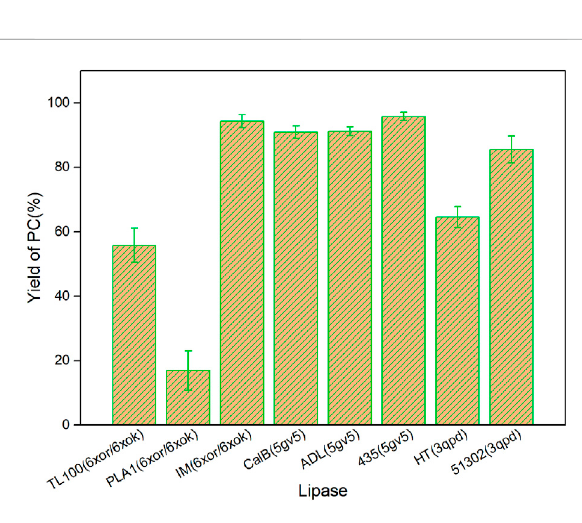
FIGURE 4 Yield of the product PC for different lipase-mediated transesteri fi cations; Reaction conditions: 20 mg PC, 1.0 g algae oil, lipase (10 µL for liquid lipases and 20 mg for immobilized lipases), 45 ° C, 500 rpm, 1